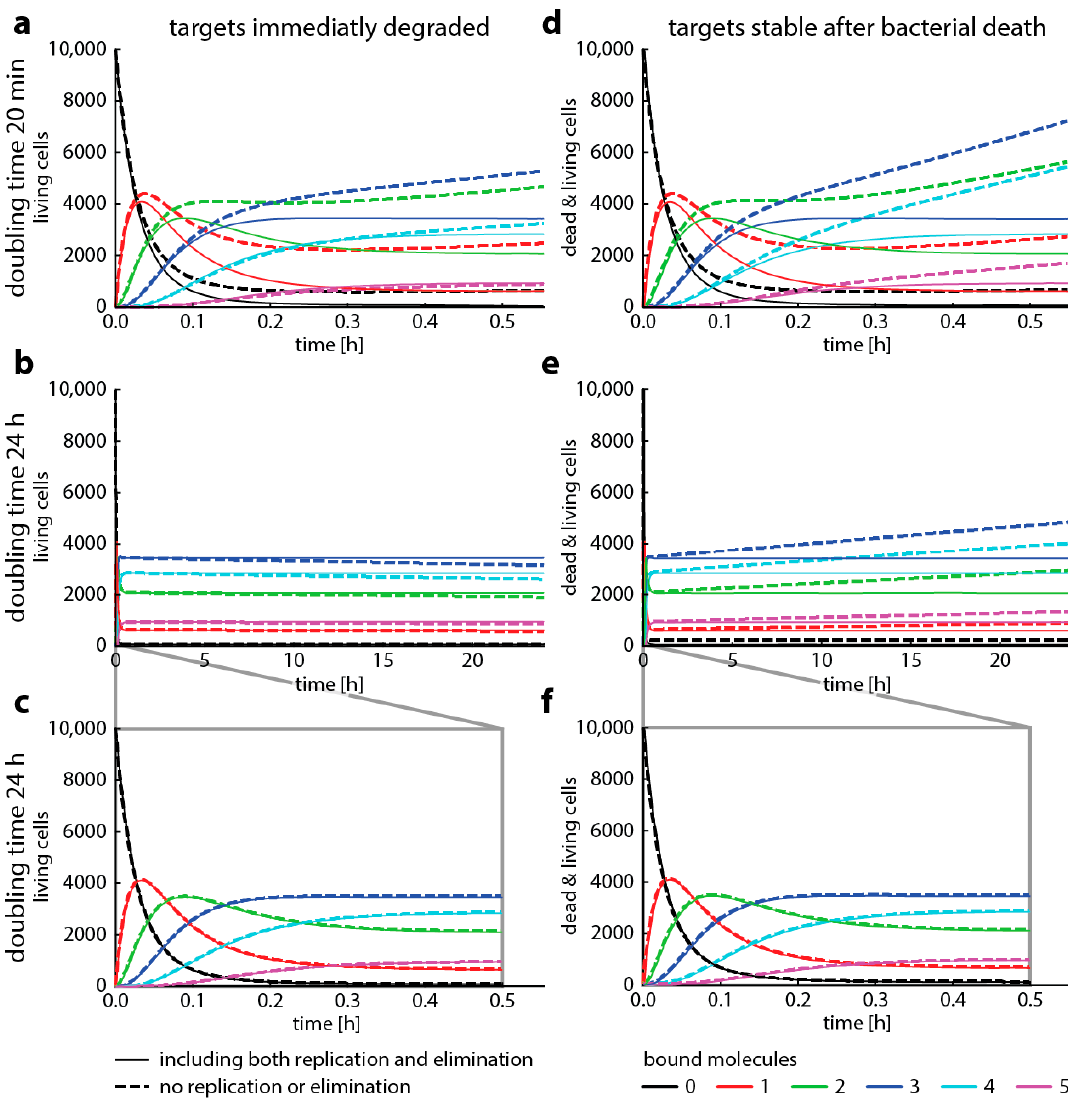
Figure 4. Bacterial replication changes target occupancy. This graph shows how target occupancy with replication and death (dashed lines) changes compared to target occupancy without replication or death (solid lines, compare to Figure 2) for two different cases. Cases, where the drug targets are immediately degraded after bacterial death (left column) or remain stable after bacterial death (right column). All parameters are the same as in Figure 3, with added replication and adjusted death rates. We assume that replication immediately ceases when more than two target molecules are bound and that cell die immediately when there are at least 4 bound target molecules. The doubling time ( ln replication rate ) is either 20 min (top panel) or 24 h (mid and bottom panels). The bottom panel highlights the first 30 min of the mid panel time course. The death rate is always 2 x the replication rate. ( a – c ) show the number of living bacteria only, ( d – f ) show both living and dead